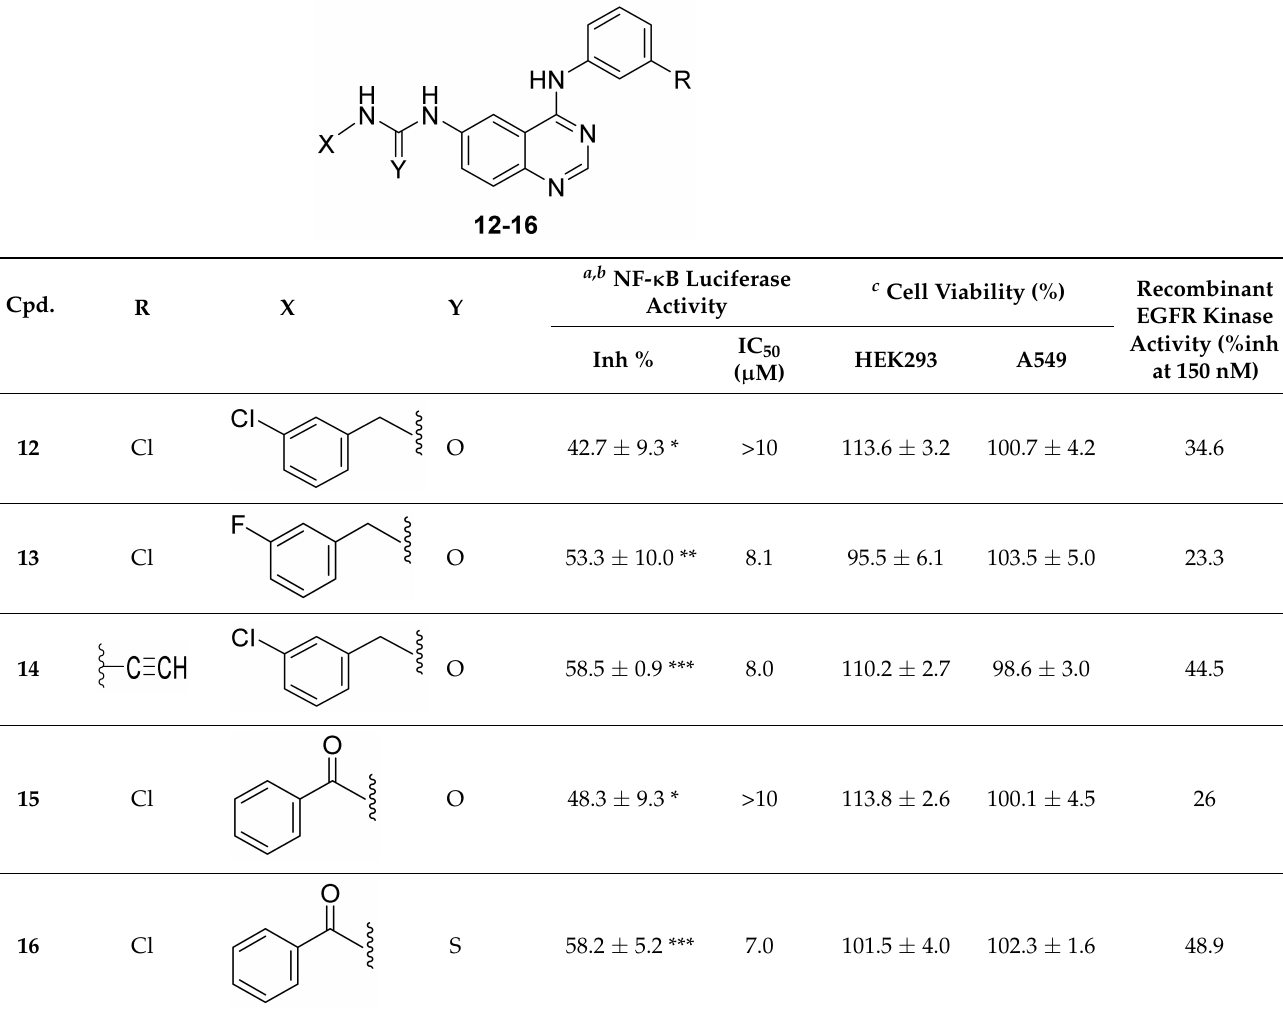
Table 2. Biological activities of NF- κ B inhibitors with benzyl urea and benzoyl (thio)urea moieties.